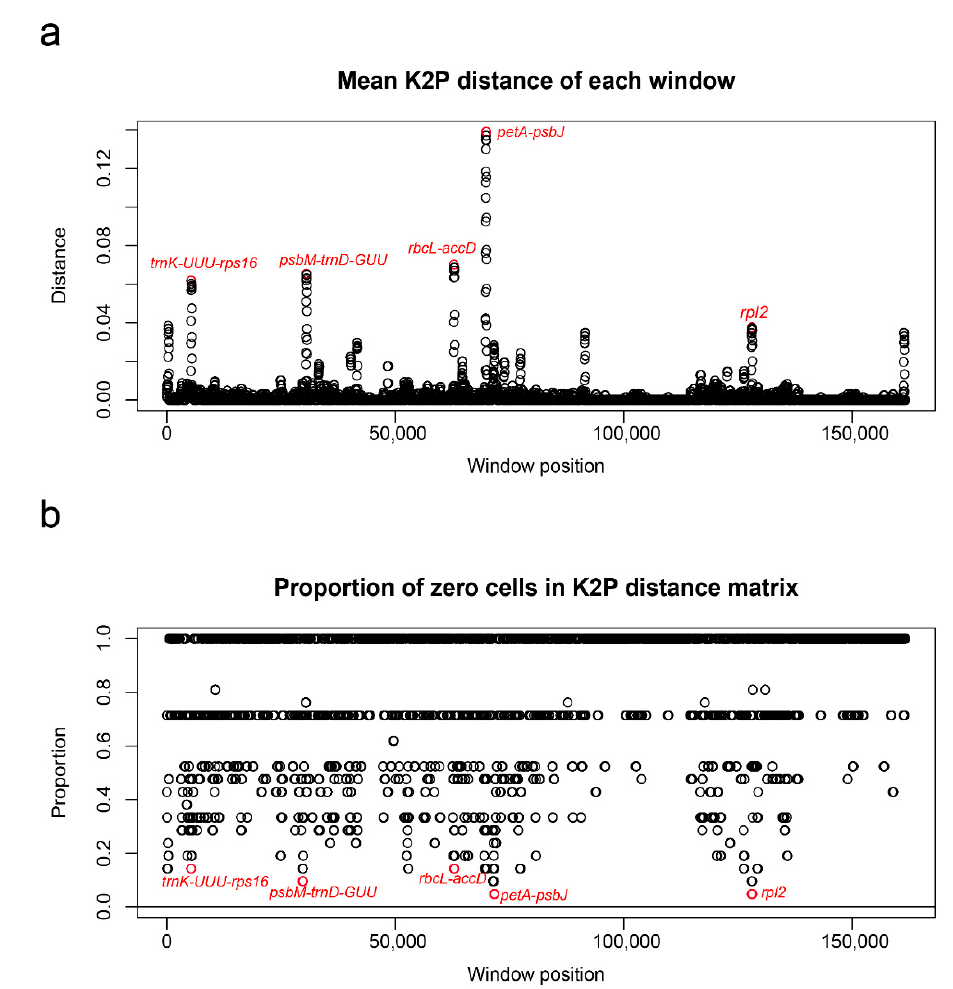
Figure 5. Identification of most divergent cp sequences among four Castanea species. ( a ) Mean distance between sequences from pairwise comparisons of all eight cp genomes based on 800 bp windows. ( b ) The proportion pairwise comparisons of eight Castanea cp genomes with zero pairwise distance over sliding 800 bp windows. In both ( a ) and ( b ) regions of maximum differentiation are indicated in red.